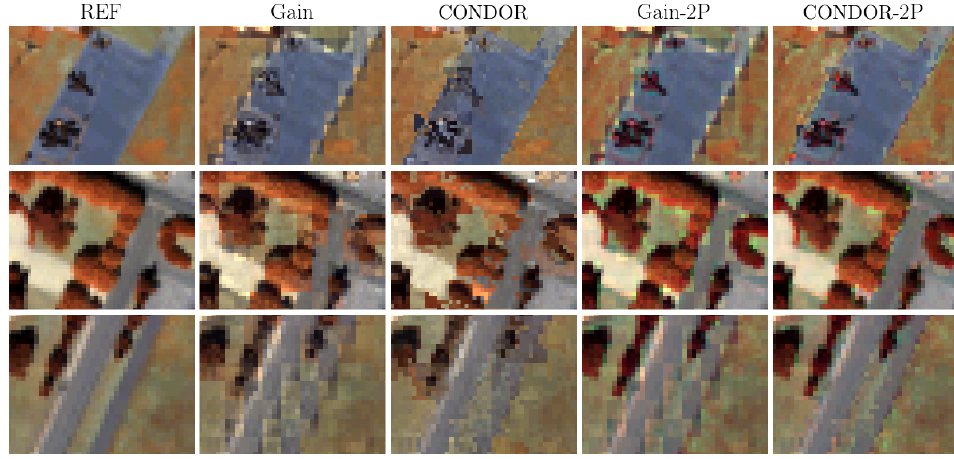
Figure 14. “Toulon” peri-urban dataset: local visual results (SWIR colour composite images; spatial resolution: 1.5 m).